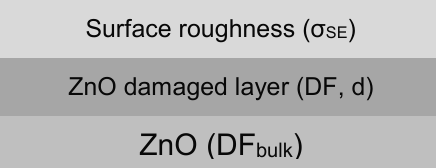
Figure 5. Physical model for spectroscopic ellipsometry (SE) representing the nanopatterned ZnO samples.